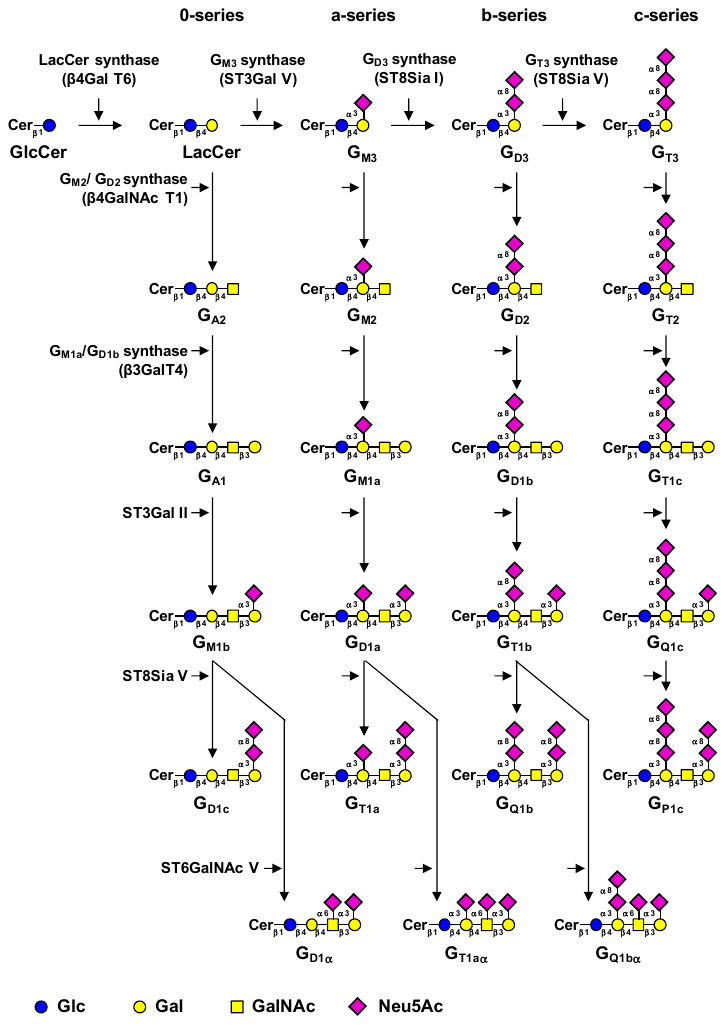
Figure 3. Biosynthesis pathways for gangliosides. Gangliosides are synthesized by stepwise addition of monosaccharides to ceramide (Cer). Ceramide is the acceptor for UDP-Glc: ceramide β - D -glucosyltransferase. Extension of GlcCer occurs by the action of UDP-Gal: GlcCer β 1,4-galactosyltransferase to make lactosylceramide (LacCer). The action of ST3Gal V (GM3 synthase), ST8Sia I (GD3 synthase), and ST8Sia V (GT3 synthase) leads to the biosynthesis of the precursors of a-, b-, and c-series gangliosides, respectively. The 0-series gangliosides are directly synthesized from LacCer. Elongation is performed by the sequential action of N -acetylgalactosaminyltransferase ( β 4GalNAc T1), galactosyltransferase ( β 3Gal T4), and sialyltransferases (ST3Gal II and ST8Sia V). α - Series gangliosides derive from the action of ST6GalNAc V on G M1b , G D1a , or G T1b . The code names of gangliosides are according to Svennerholm [84]. Data from Bobowski et al. [85]. After the synthesis of these precursors, GalNAc, Gal, and Neu5Ac residues can be transferred in a stepwise manner by the β 1,4- N -acetylgalactosaminyltransferase I (GM2/GD2 synthase) [86], the β 1,3-galactosyltransferase IV [87], and sialyltransferases (Figure 3). The β 1,4- N -acetyl- galactosaminyltransferase I ( β 4GalNAc T1) is active on the four series of gangliosides and converts LacCer, G M3 , G D3 , and G T3 into G A2 (asialo-G M2 ), G M2 , G D2 , and G T2 , respectively [88,89]. Similarly, the β 1,3-galactosyltransferase IV ( β 3Gal T4) equally uses G A2 , G M2 , G D2 , and G T2 as acceptor substrates [88]. The terminal Gal residue can be further used as acceptor substrate by the α 2,3-sialyltransferase ST3Gal II [90]. Finally, the terminal trisaccharide Neu5Ac α 2-3Gal β 1-3GalNAc can be further